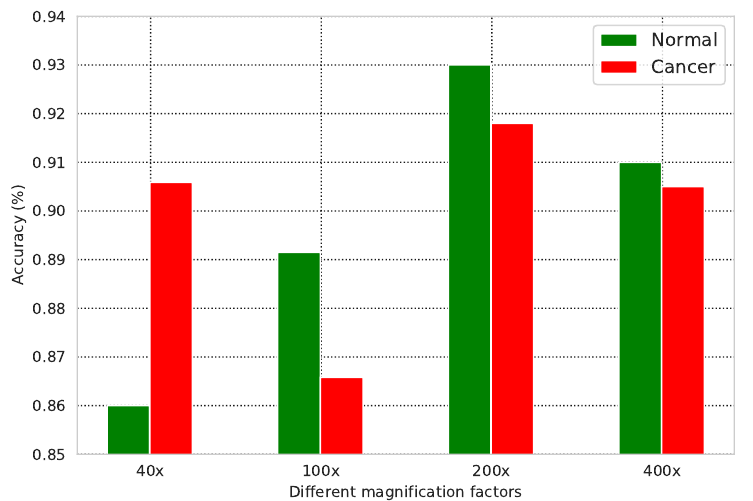
Figure 10. Benign or malignant prediction accuracy for the various magnification factors.